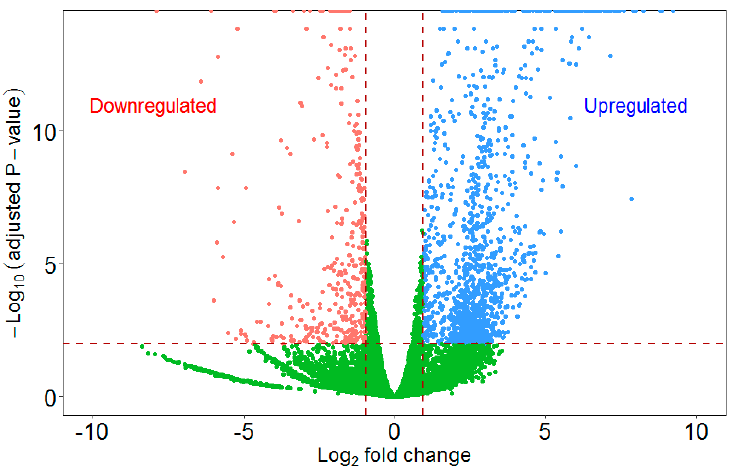
Figure 3. Volcano plot of differentially up- and downregulated genes in the infected zooids relative to the uninfected control zooids. A volcano plot shows the relationship between the p -values of a statistical test and the magnitude of the difference in expression values. On the y-axis the negative log 10 p -values are plotted. On the x-axis the log 2 values of the fold changes seen in whole transcriptome comparison. The heatmap displaying the broad patterns of gene expression (Figure 4) in the infected zooids highlighted a subset of genes that were activated in response to T. bryosalmonae .